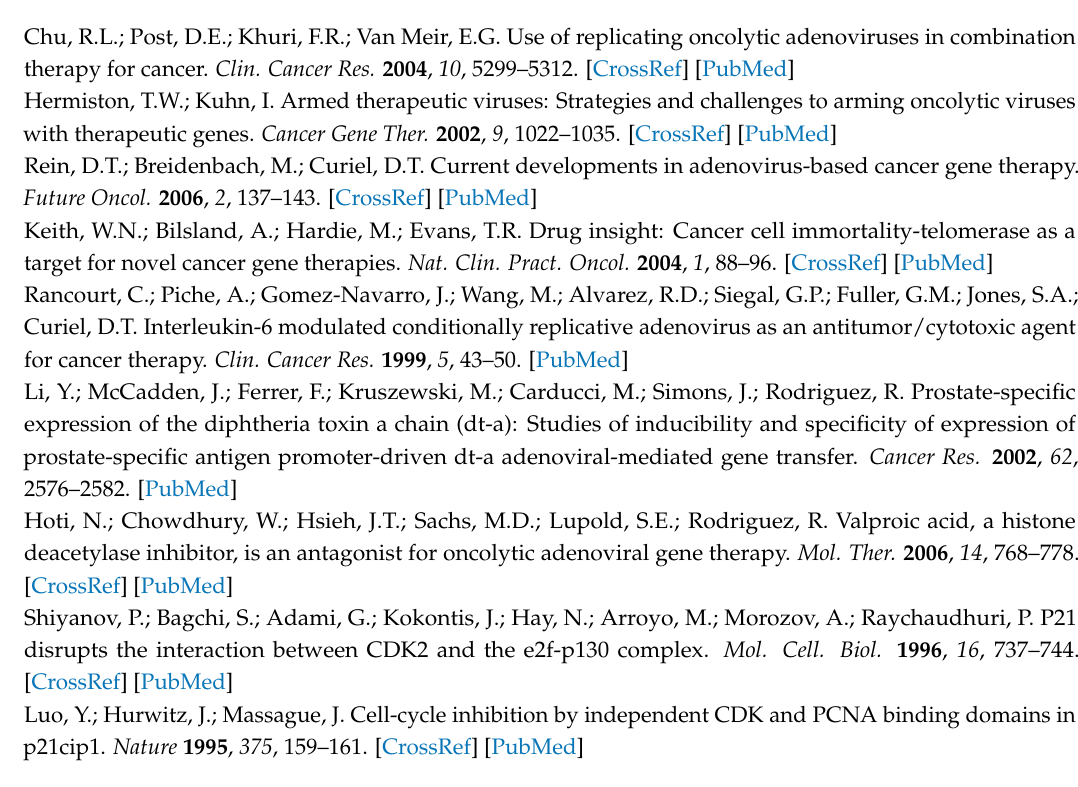
Table S1: Generated custom probe set for human adenovirus type